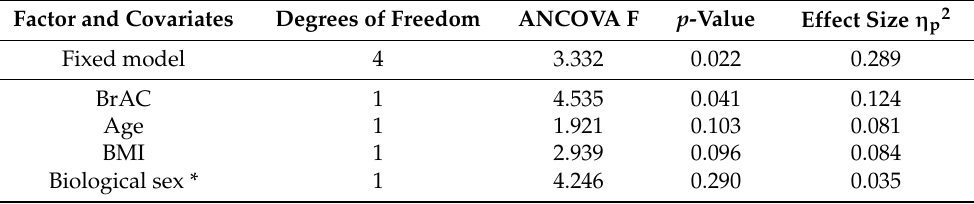
Table 4. Results of the ANCOVA test indicating the degrees of freedom, the F statistic, the significance level ( p -value), and the effect size ( η p2) for the factor (*) and covariates (BrAC, BMI and age) included in the model. Factor and Covariates p